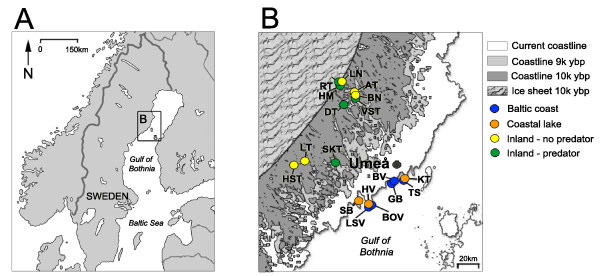
Study sites in northern Sweden. A) Location of the study area B) Enlargement of study area and study sites. Current and past coastlines (in calibrated years before present) are shown.